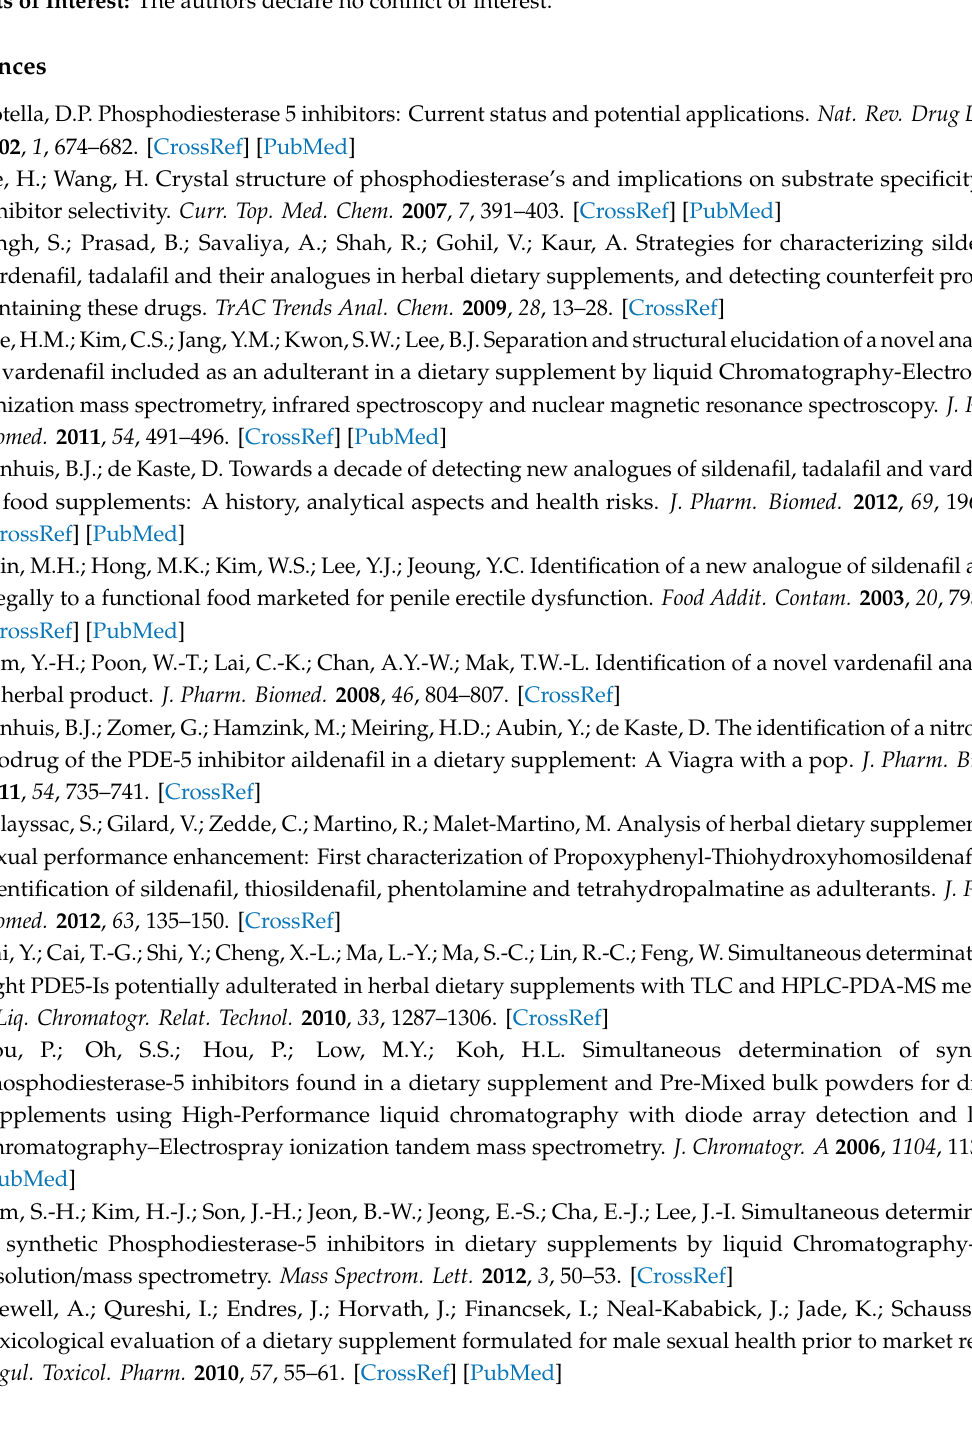
state of the ions; Figure S15: Representative MS n ( n = 2, 3) spectra and proposed fragmentation mechanisms of chloropretadalafil ( A ) and N -octyltadalafil ( B ). The bracketed numbers next to the m / z values indicate the charge state of the ions; Table S1: Accurate masses and mass errors for fragment and precursor ions of PDE-5 inhibitors and their analogs; Table S2: The structures of PDE-5 inhibitors and their